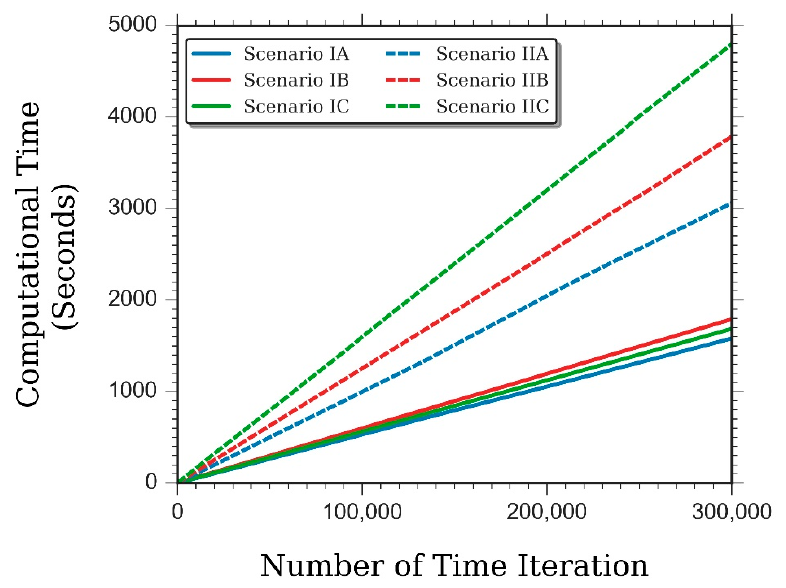
Figure 10. Computational overhead of disparate LBM schemes in modelling Rayleigh-Bènard convection with aspect ratio = 1, Ra = 10 4 , Pr = 0.71, τ υ = 0.6 and Ma = 0.1, starting from the transient period up to the accomplishment of the quasi-steady-state period.